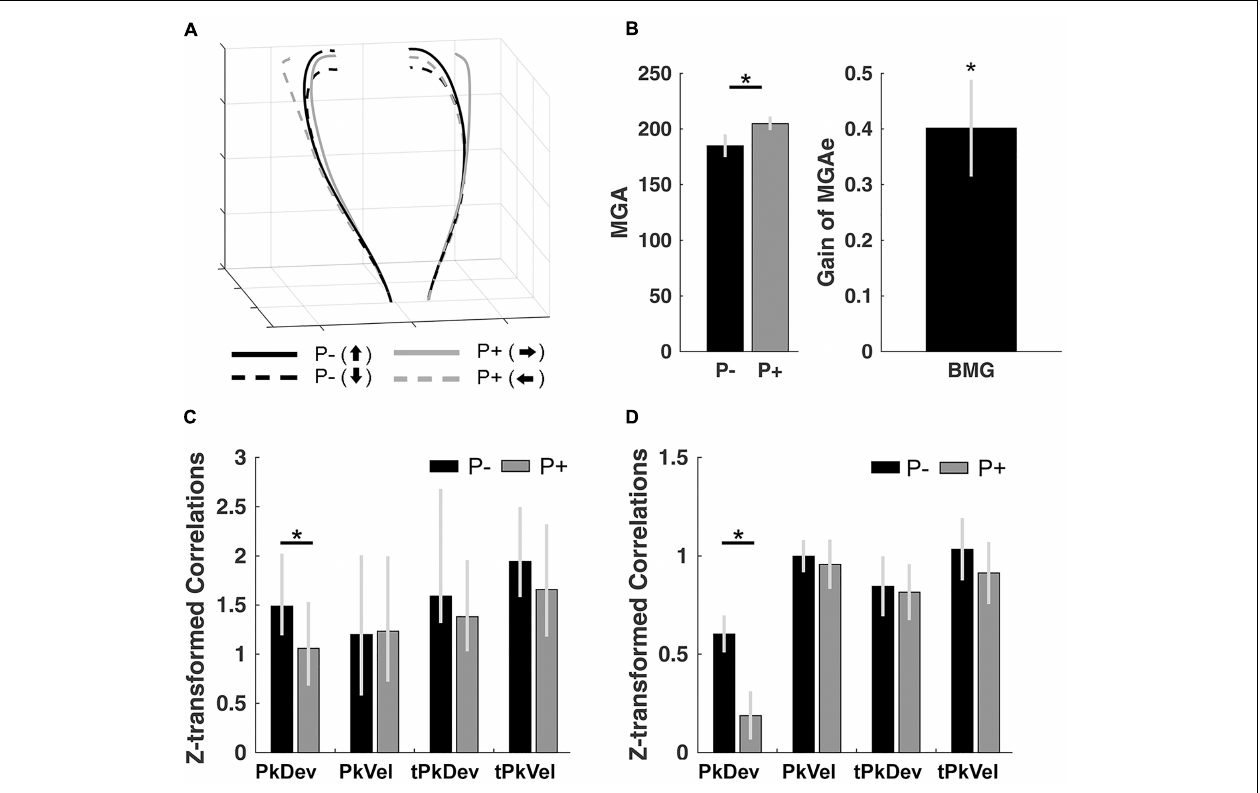
FIGURE 2 | Control experiment results. (A) Normalized trajectories of bimanual grasping for the left and right hands from movement onset to object contact. P–, no perturbation; P+, perturbation. Arrows pointing up/down/left/right: final orientation of the object. (B) Size of MGAe during perturbation (P+) and no-perturbation (P–) trials, and the scaling of MGAe to different object widths. Gain = [MGA of object width in P+ trials – MGA of object width in P– trials] / [P+ object width – P– object width]. Error bars indicate standard error. (C) Synchrony of peak finger deviation (PkDev), peak finger velocity (PkVel), timing of peak finger deviation (tPkDev), and timing of peak finger velocity (tPkVel) between the left and right hands in each of the perturbation conditions (P–, no perturbation; P+, with perturbation) quantified using correlations across persons (Fisher’s z -transformed). Error bars indicate 95% bootstrapped confidence interval. (D) Same-trial coordination quantified using within-subject correlations (Fisher’s z -transformed) of reach-to-grasp kinematics and timing variables in each of the perturbation conditions. ∗ Indicates significance at p < 0.05.